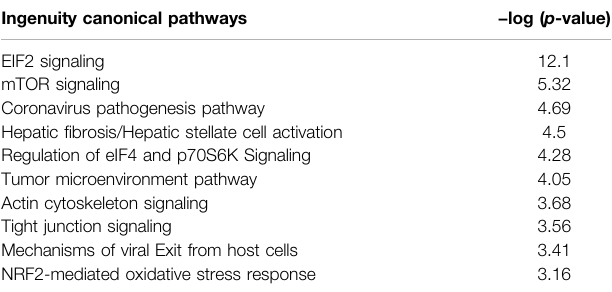
TABLE 2 | Top 10 canonical pathways in WT versus STARD11-/- PAEV proteins. Ingenuity canonical pathways − log ( p